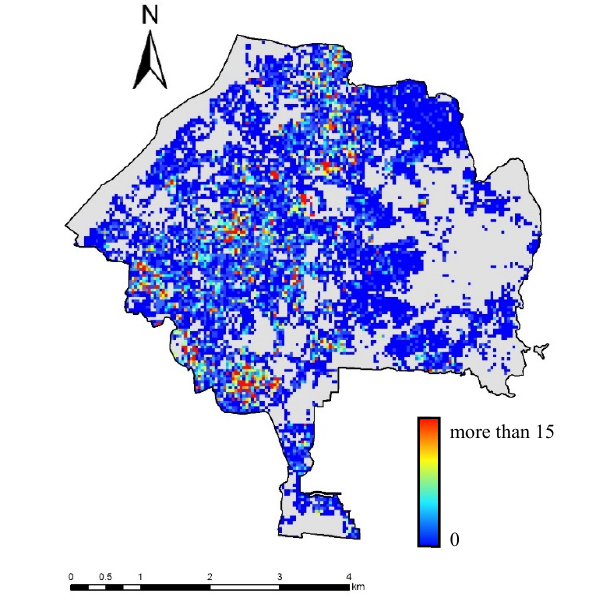
Figure 2. Distributions of the water hydrants classified as “Vacant house”. Gradations in colour from blue to red denote the number of water hydrants in the 40 m by 40 m